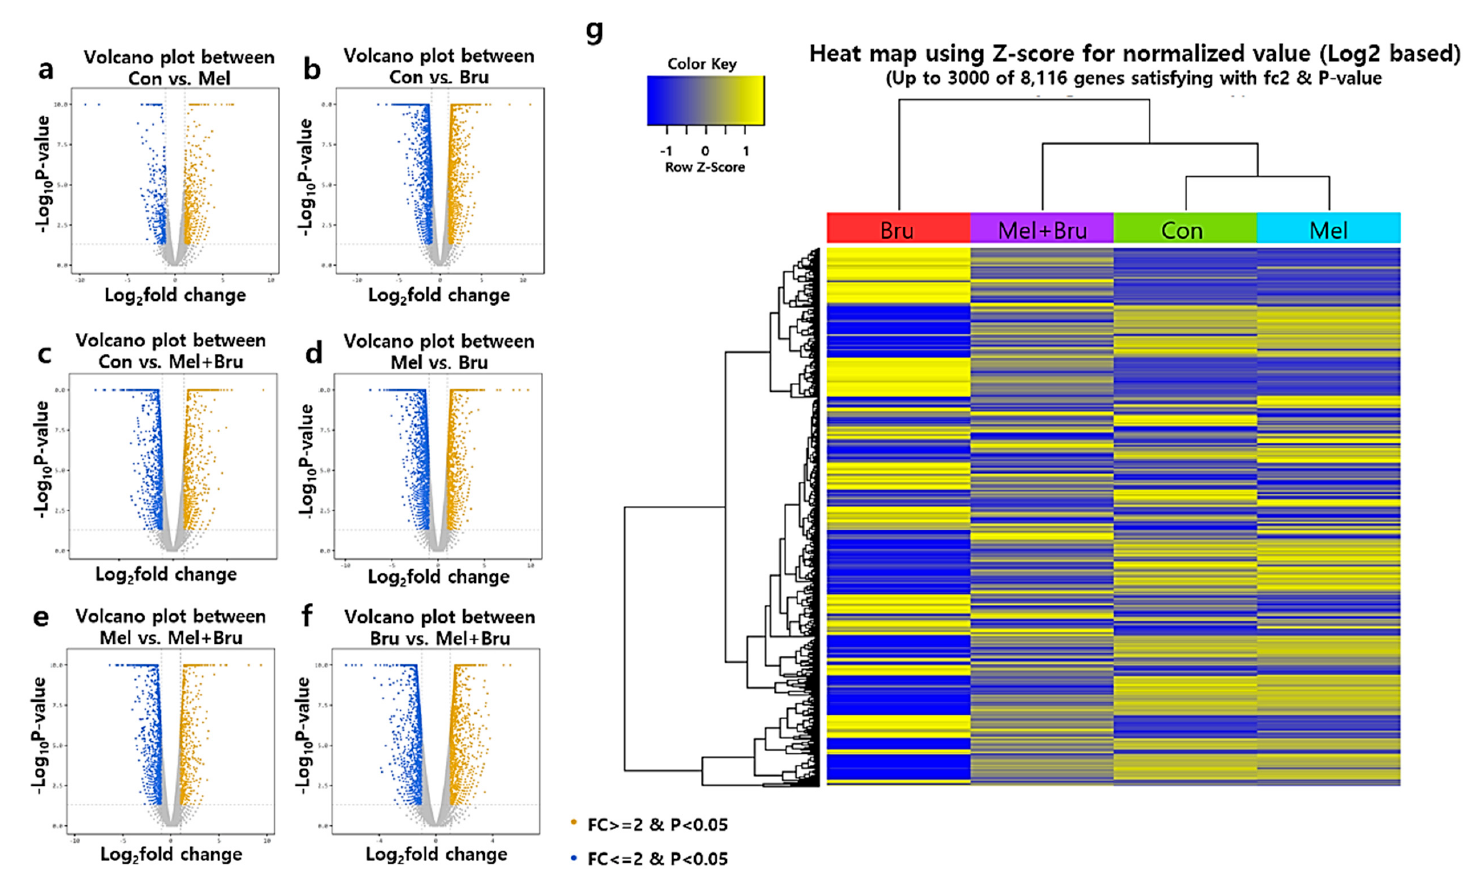
Figure 4. General gene expressions in porcine COCs from the four experimental groups (control, melatonin, brusatol, and co-treatment). ( a – f ) Total of six cases of gene expression comparisons were compared: Con vs. Mel, Con vs. Bru, Con vs. Mel + Bru, Mel vs. Bru, Mel vs. Mel + Bru, and Bru vs. Mel + Bru. Yellow dots indicate gene expression changes of up-regulated genes that have more than 2-fold higher with p < 0.05, and blue dots indicate expression changes of down-regulated genes that have more than two-fold lower with p < 0.05. ( g ) A heat map was generated using the normalized value from each experimental group, it showed up to 3000 of 8116 genes satisfying with two-fold changes and p < 0.05. Con; control, Mel; melatonin, Bru; brusatol, and Mel + Bru; melatonin + brusatol. At least 1100 porcine COCs per experimental group were collected from eight biological